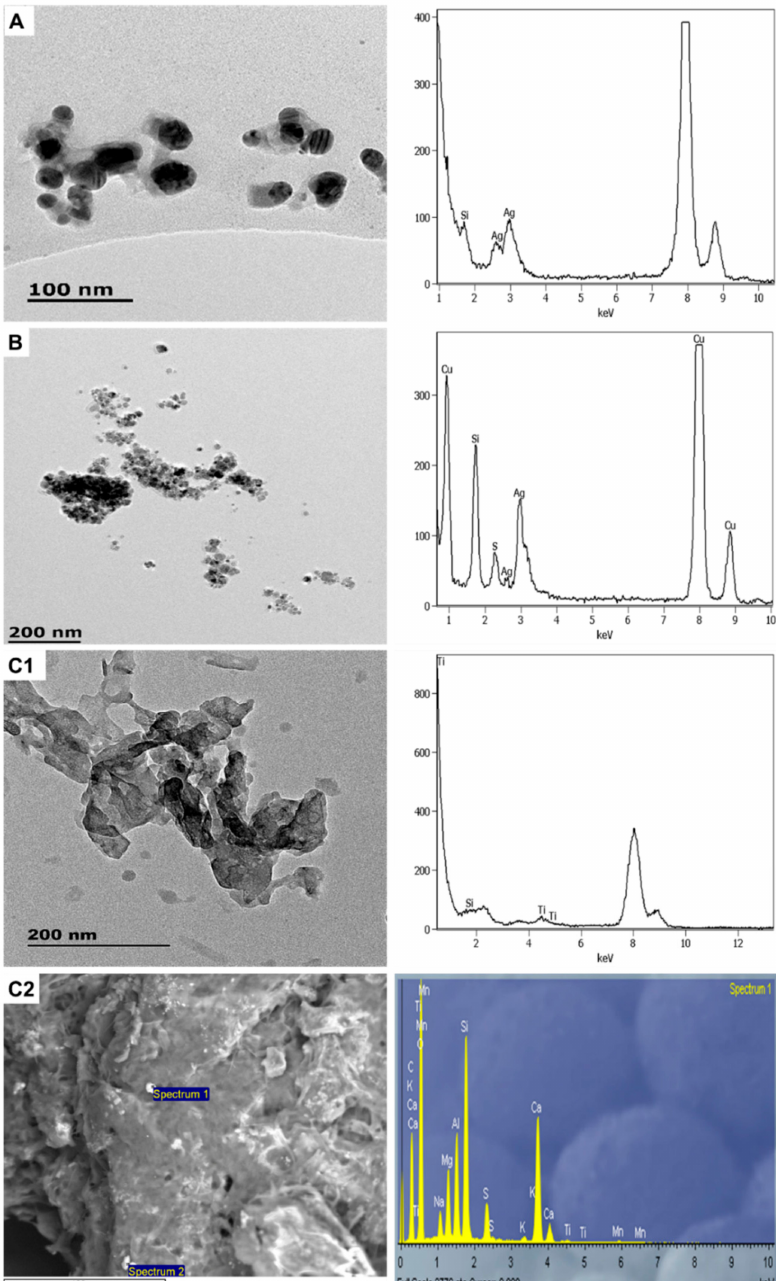
Figure 6. The TEM- and SEM-EDX characterisation of ENMs incorporated in SAN1 ( A ), SAN2 ( B ), and SAN3 ( C1 , C2